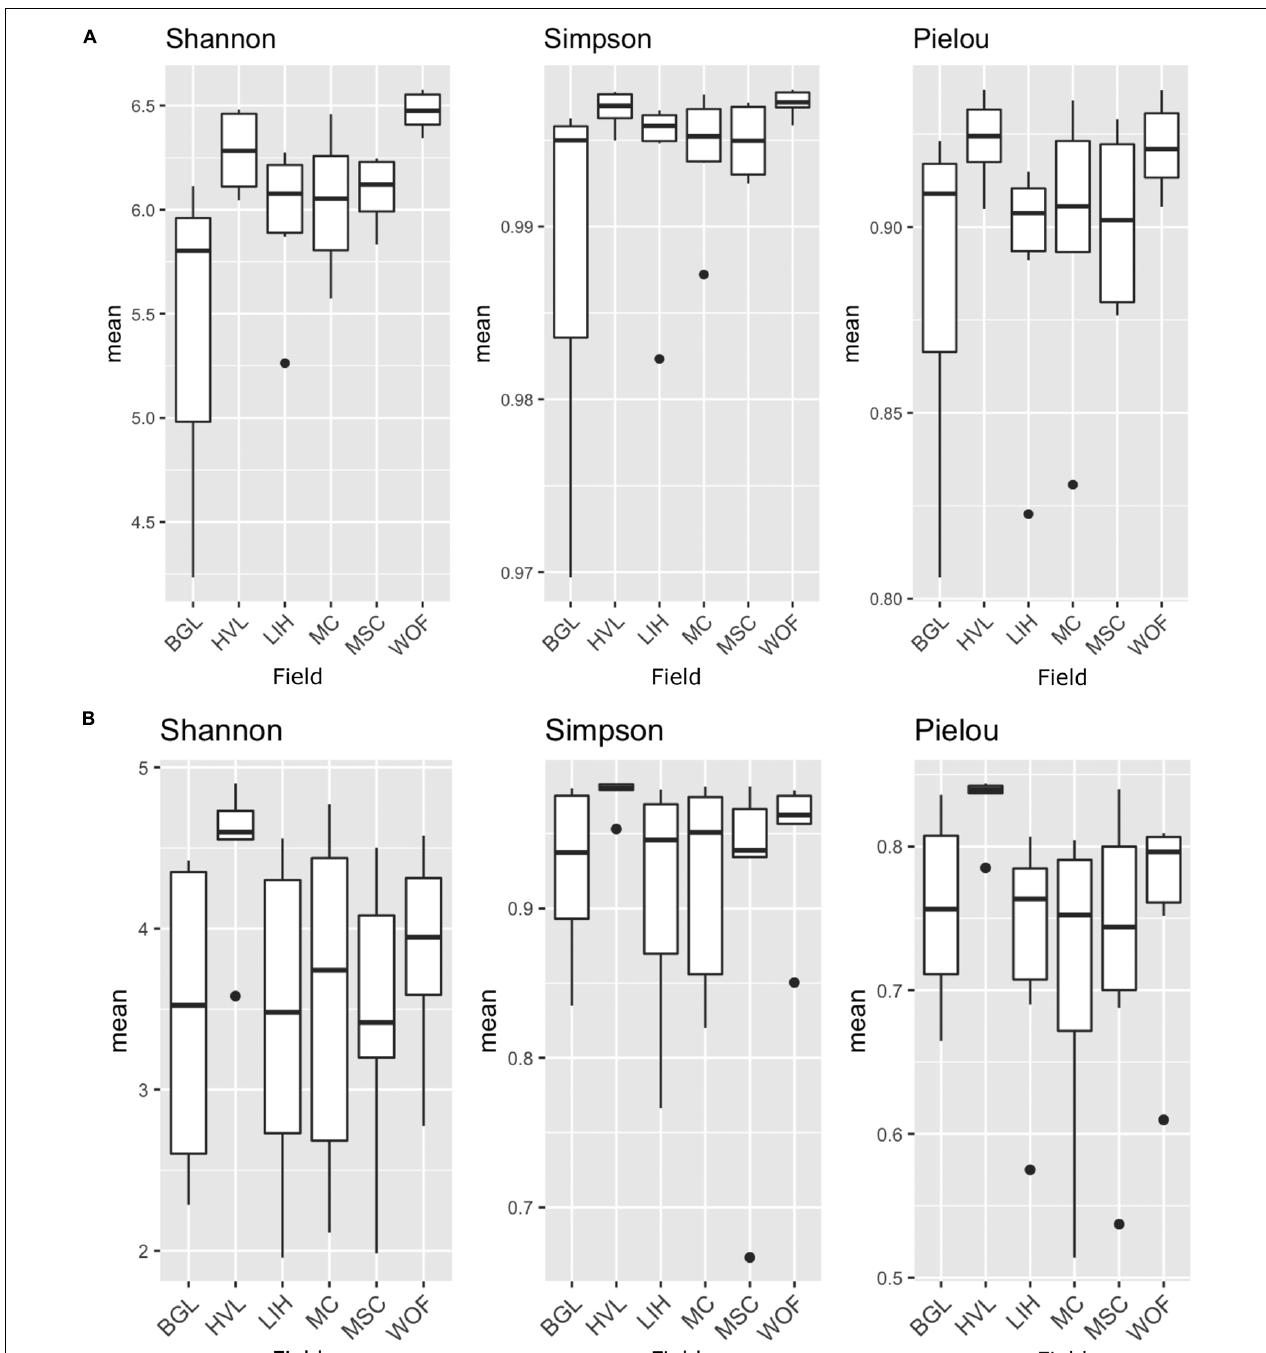
FIGURE 2 | Microbial species diversity and evenness in different hemp fields. The analysis of alpha diversity indices (Shannon and Simpson) and Pielou’s evenness index of the bacterial and fungal communities: (A) bacterial microbiota; (B) fungal microbiota. Indices are shown according to fields. Field name: BGL, Bluegrass Lane; HVL, Hudson Valley Lab; LIH, Long Island Horticultural Research and Extension Center; MC, McCarthy CBD Trial; MSC, McCarthy Stress Trial; and WOF, Wegman’s Organic Farm. Three replicates were used for the analysis of species diversity and evenness.